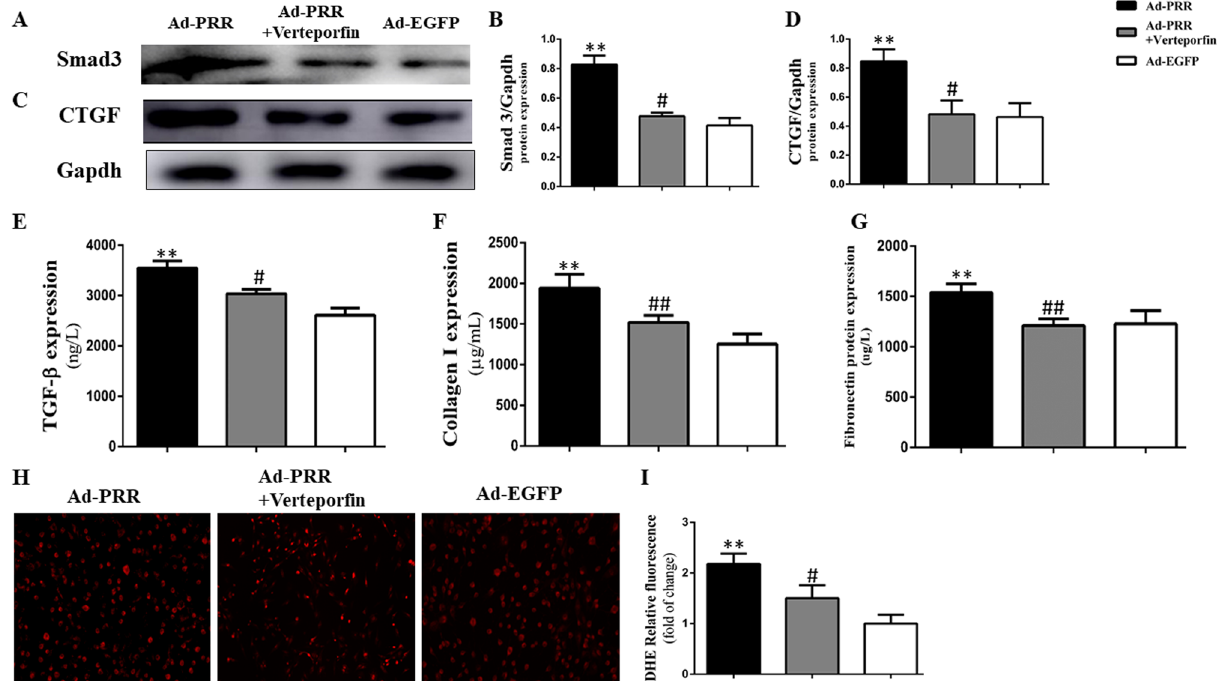
Figure 4. Smad3 and CTGF protein expression; TGF-β, collagen I and fibronectin expression and ROS production in cardiac fibroblasts (CFs) from the 3 groups. ( A ) Western blot showing Smad3 protein expression. Figure ( A ) is cropped picture, omitting the repeated blots from the same group. The full-length blots/gel is complemented in supplementary figure 4. ( B ) Quantitative analysis of the results shown in ( A ). ( C ) Western blot showing CTGF protein expression. ( D ) Quantitative analysis of the results shown in ( C ). ( E – G ) ELISA of TGF-β, collagen I, and fibronectin protein expression. ( H ) DHE showing ROS production in the 3 groups. ( I ) Quantitative analysis of the results shown in ( H ). ** p < 0.01 compared with the Ad-EGFP group, # p < 0.05, ## p < 0.01 compared with the Ad-PRR